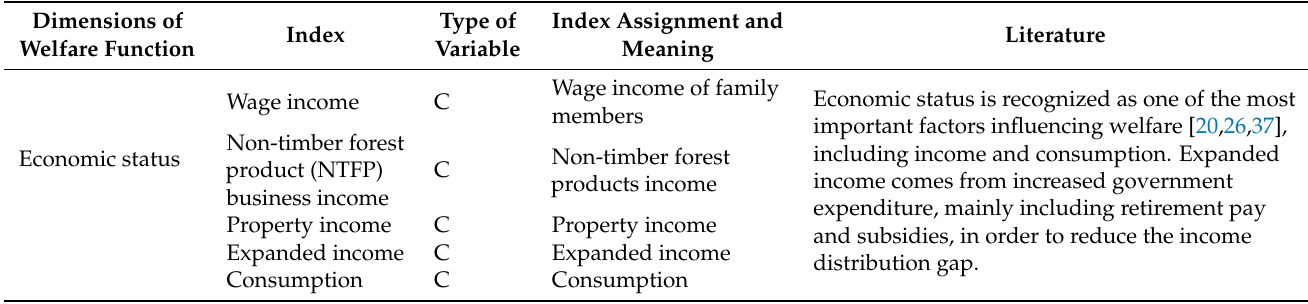
Table 1. Indices for evaluating worker household